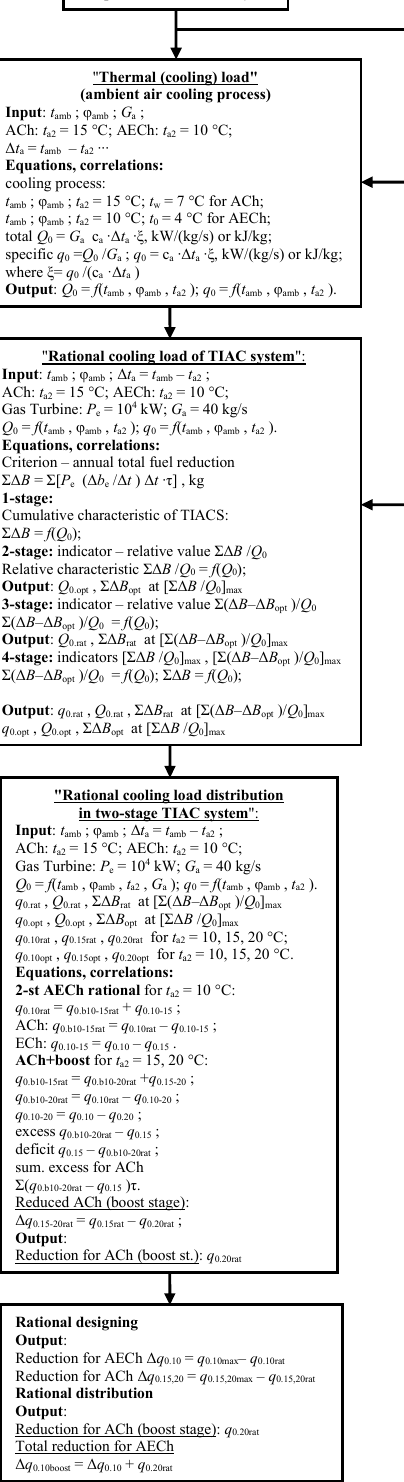
Figure A1. Flow chart of calculation procedure.